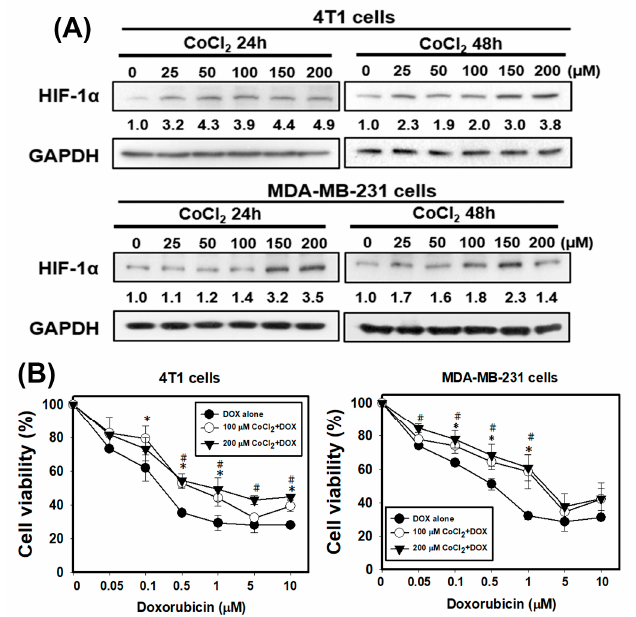
Figure 2. The chemical hypoxia (CoCl 2 ) stabilizes hypoxia-inducible factor 1 α (HIF-1 α ) protein and causes doxorubicin (DOX) resistance in TNBC cells. ( A ) the protein level of HIF-1 α in 4T1 and